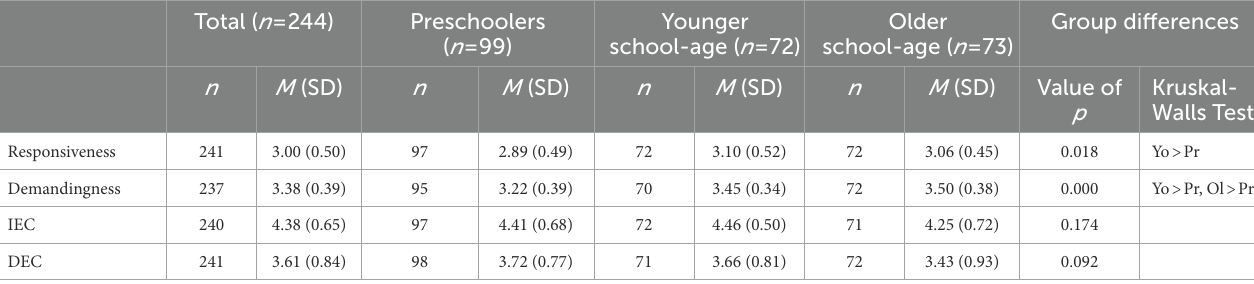
TABLE 1 Sample descriptive separately for the three age